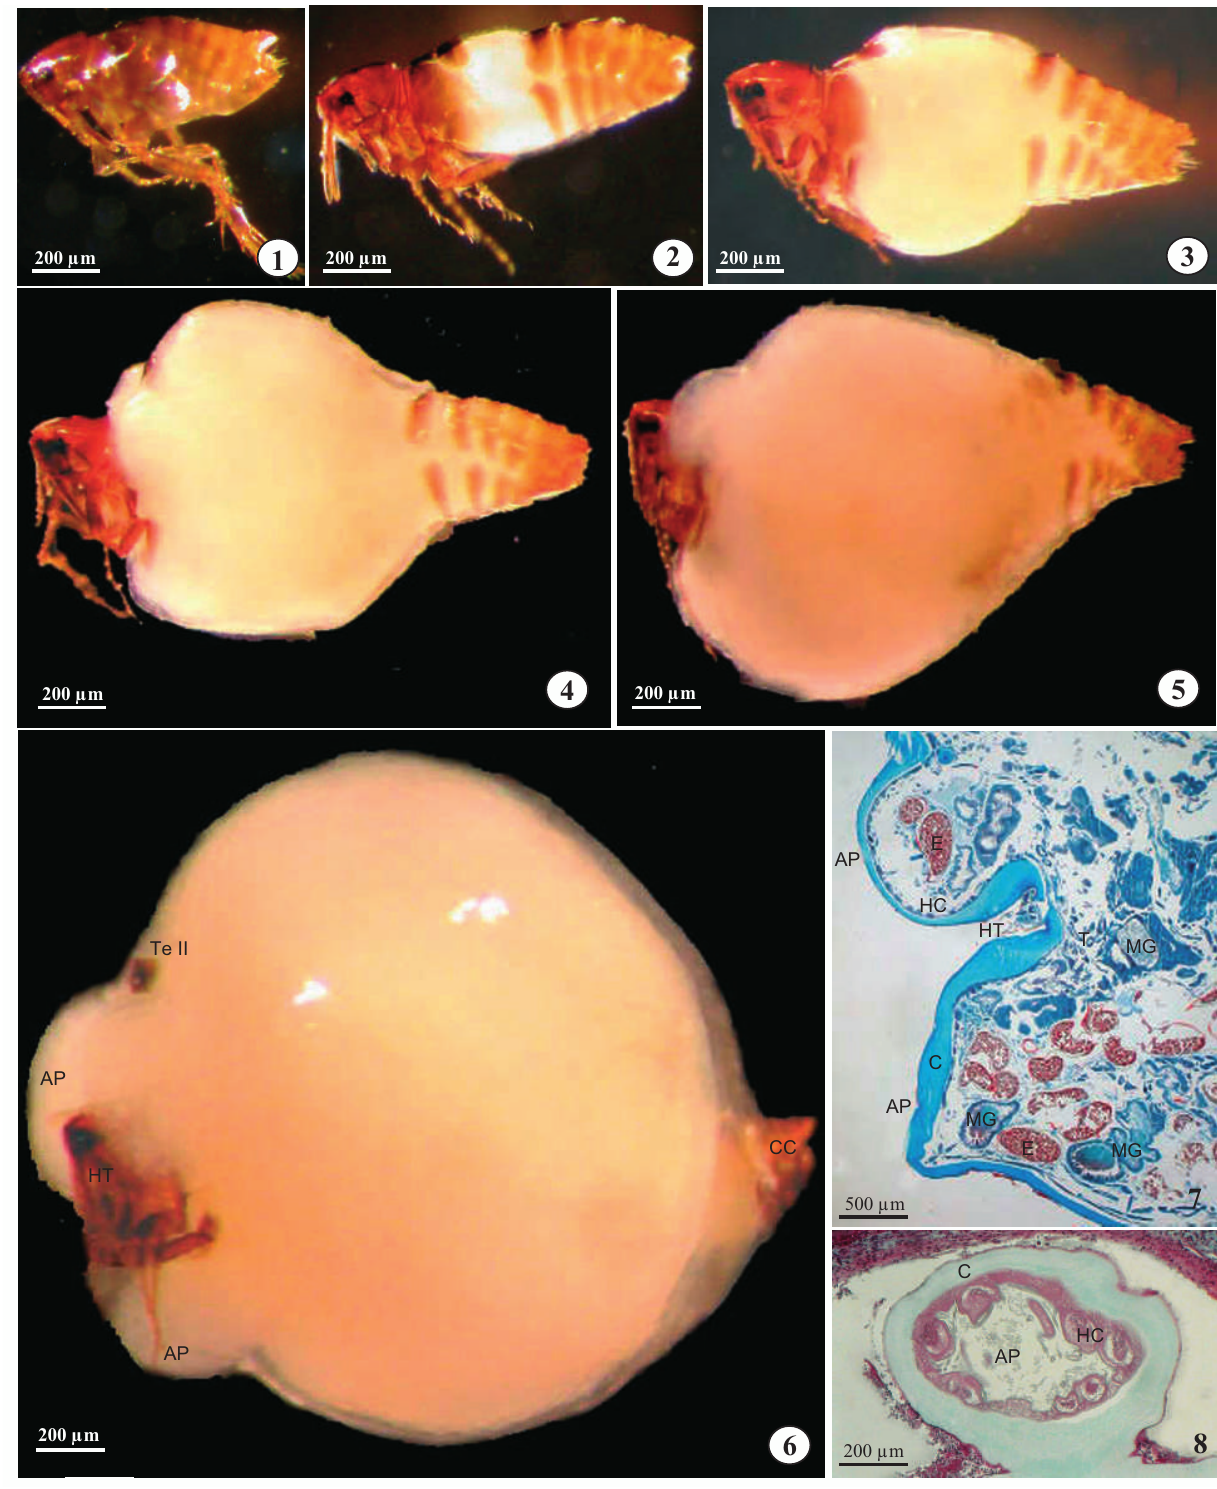
Plate IV. – Neosomic development of T. trimamillata from a non-gravid to a 3/4 grown gravid female (Figs 1-6); AP = anterior protube- rances; C = cuticula; CC = caudal cone; E = eggs; HC = hypodermal cells in an anterior protuberance; HT = head and thorax; MG = midgut; T = tracheae; Te II = tergum of II abdominal segment. (Stains: Heidenhaim Azan = Fig. 7; Masson Goldner = Fig. 8; without stain = Figs 1, 2, 3, 4,